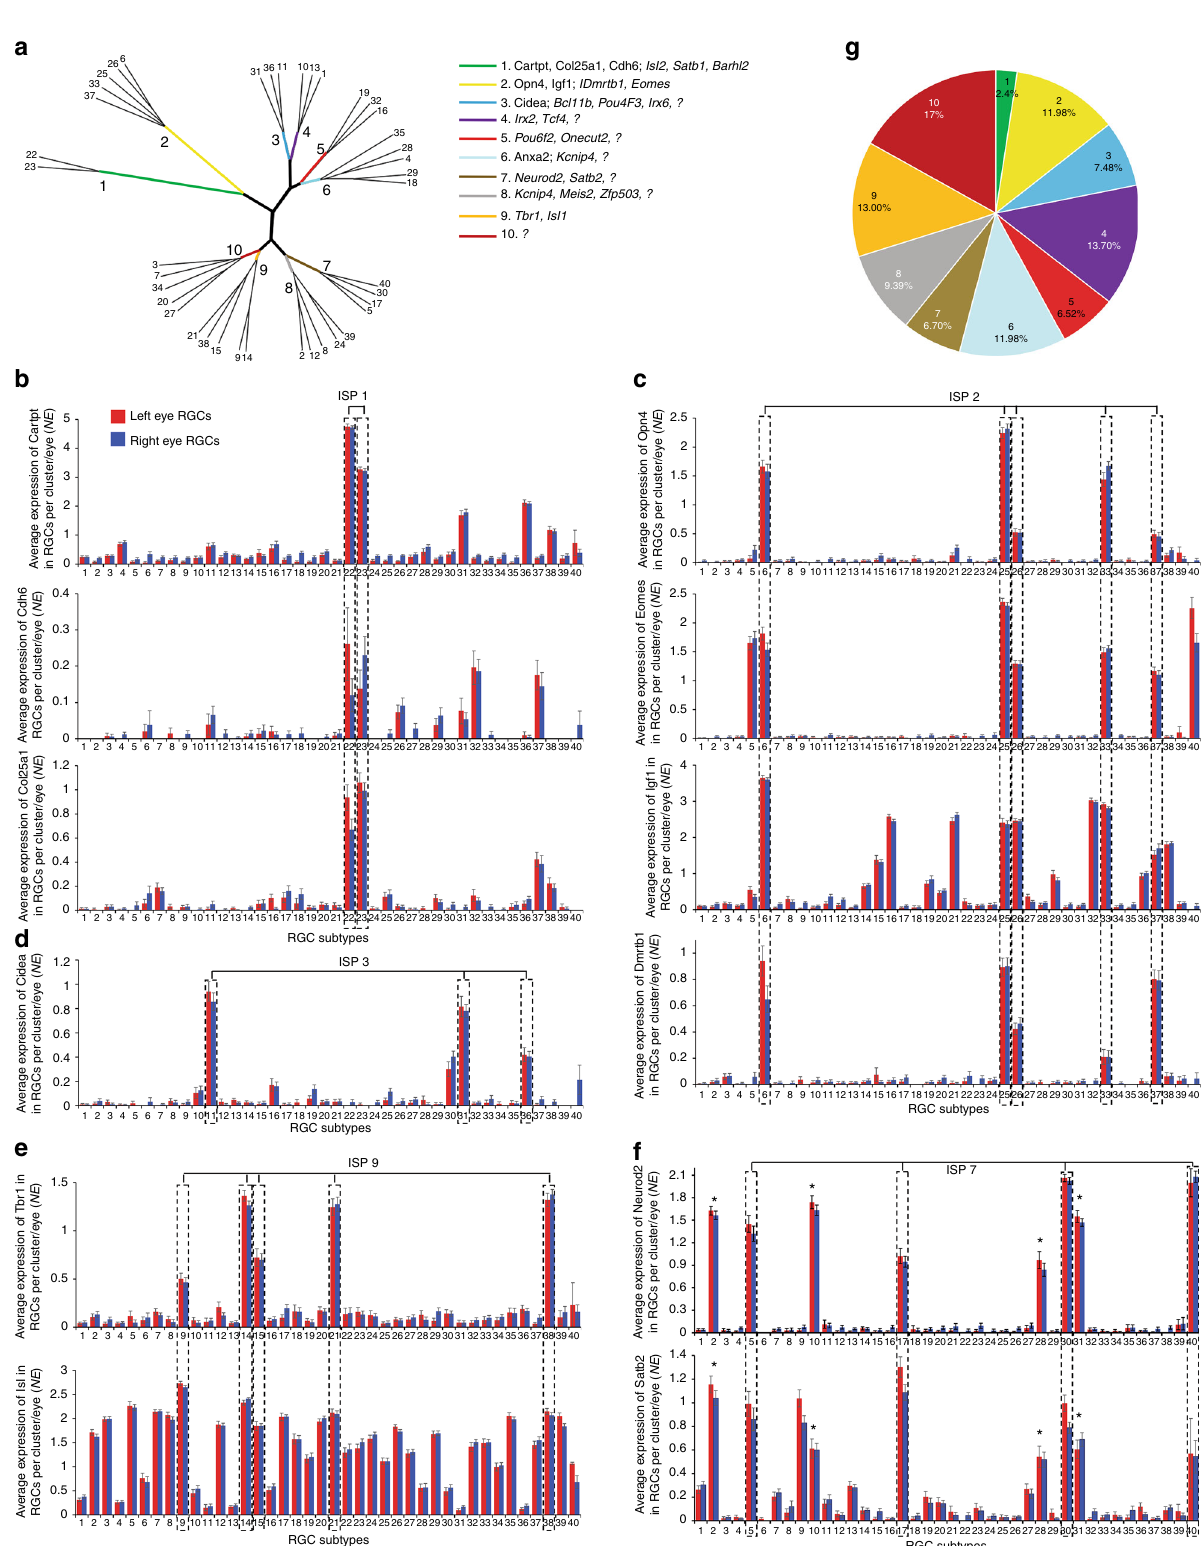
Fig. 7 RGC subtypes diversi fi cation. a Circular phylogenetic tree-style diagram of RGC subtypes hierarchical diversi fi cation. The distance of a branch from the center point represents the extent of its divergence, and rami fi cation of the branches represents the hierarchical relationship between RGC subtypes transcriptome pro fi les. Genes enriched in color-coded intermediate branches, that represent the ISPs, are shown on the side. TFs are italicized, and where a combination of TFs is not suf fi cient to explain all the subtypes comprising the ISP, a “ ? ” represents yet undetermined TF or epigenetic/TF regulator that may participate in specifying these ISPs. b – f Expression pro fi les of genes, including TFs, which are enriched in speci fi c ISPs are shown, as marked. g The pie graph shows prevalence of the ISPs relative to the total RGC